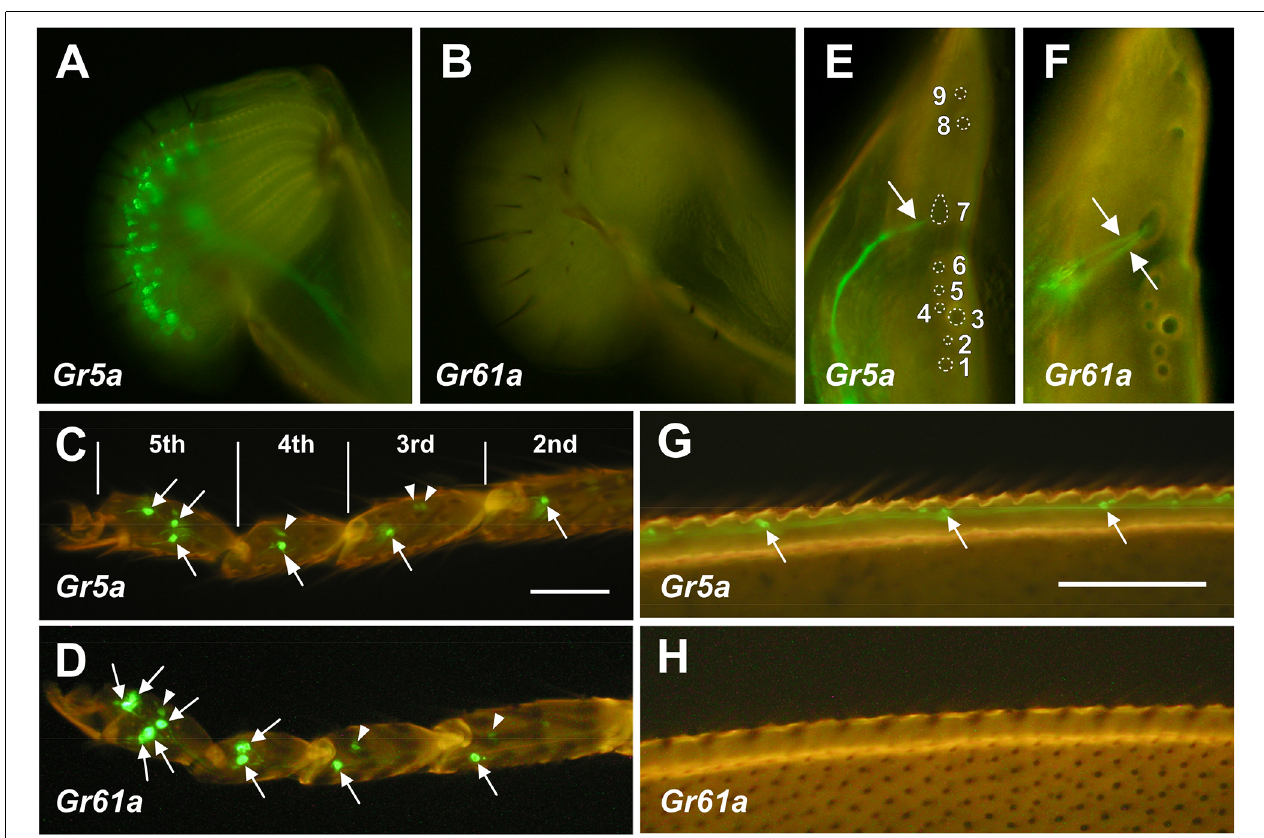
FIGURE 1 | Distributionof Gr5a + and Gr61a + GRNs in peripheral gustatory organs. (A,C,E,G) Fluorescence microscopic images of Gr5a+ GRNs of the adult flies with the genotype w ; Gr5a - Gal4 / Gr5a - Gal4 ; UAS - mCD8::GFP / UAS - mCD8::GFP.Gr5a+ GRNs are widely distributed in gustatory organs: the labial palp (A) , tarsal leg segments (C) , labral sense organ (LSO) of the pharynx (E) and wing margin (G) . (B,D,F,H) Fluorescence microscopic images of Gr61a+ GRNs of the adult flies with the genotype w ; Gr61a - Gal4 / Gr61a - Gal4 ; UAS - mCD8::GFP / UAS - mCD8::GFP . Gr61a+ GRNs were localized to the tarsus (D) and LSO (F) . (C,D) Tarsal segments of the prothoracic leg. Gr5a + (C) and Gr61a+ GRNs (D) are found in the 2nd, 3rd, 4th, and 5th tarsal segments (arrows). Additionally, small cells also express the reporter (arrowheads). (E,F) The LSO. The nine sensilla that make up the LSO are indicated by the numerals 1–9. Dendrites of a single Gr5a + GRN (E) and two Gr61a + GRNs (F) enter the 7th sensillum of the LSO (arrows). Anterior top and dorsal right view of the images in panels (E) and (F)